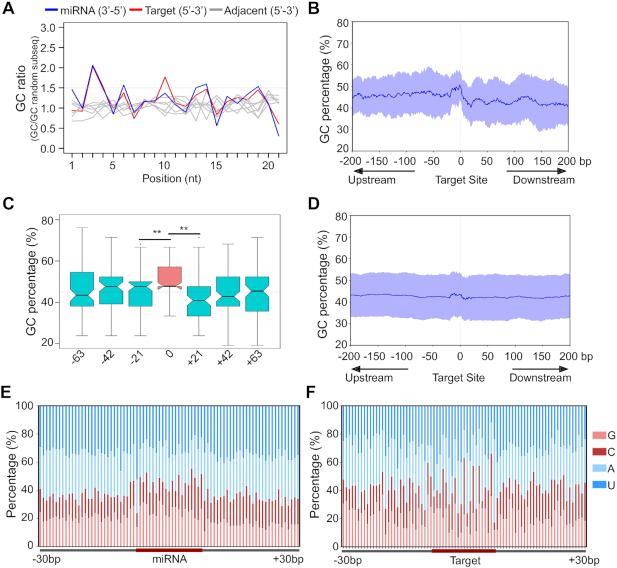
miRNA target sites in mRNAs complement miRNA GC signature. (A) Position-specific GC ratios of miRNA target regions/average cDNA GC content (85, non-redundant target sequence). Blue: miRNA, Red: target RNA, grey: an adjacent 21-nt window on the target RNA. (B) GC content across conserved miRNA target sequences (145) of A. thaliana that are experimentally verified. Mean and standard deviation of GC content around the target region was calculated as the sliding window of 21-nt represented as the blue line and light blue region, respectively. (C) GC percentages at three consecutive 21 nt windows before and after the target site (**P < 0.001, Mann–Whitney U Test). (D) GC content across miRNA target representative gene model sequences of A. thaliana that are predicted by the psRNA-Target tool (e-value cutoff of 4, 3379). (E) Position-specific GC signature of conserved miRNA across precursors in the 30-nt window (353 unique miRNAs from A. thaliana). (F) Position-specific GC signature in miRNA target regions (92 unique targets).